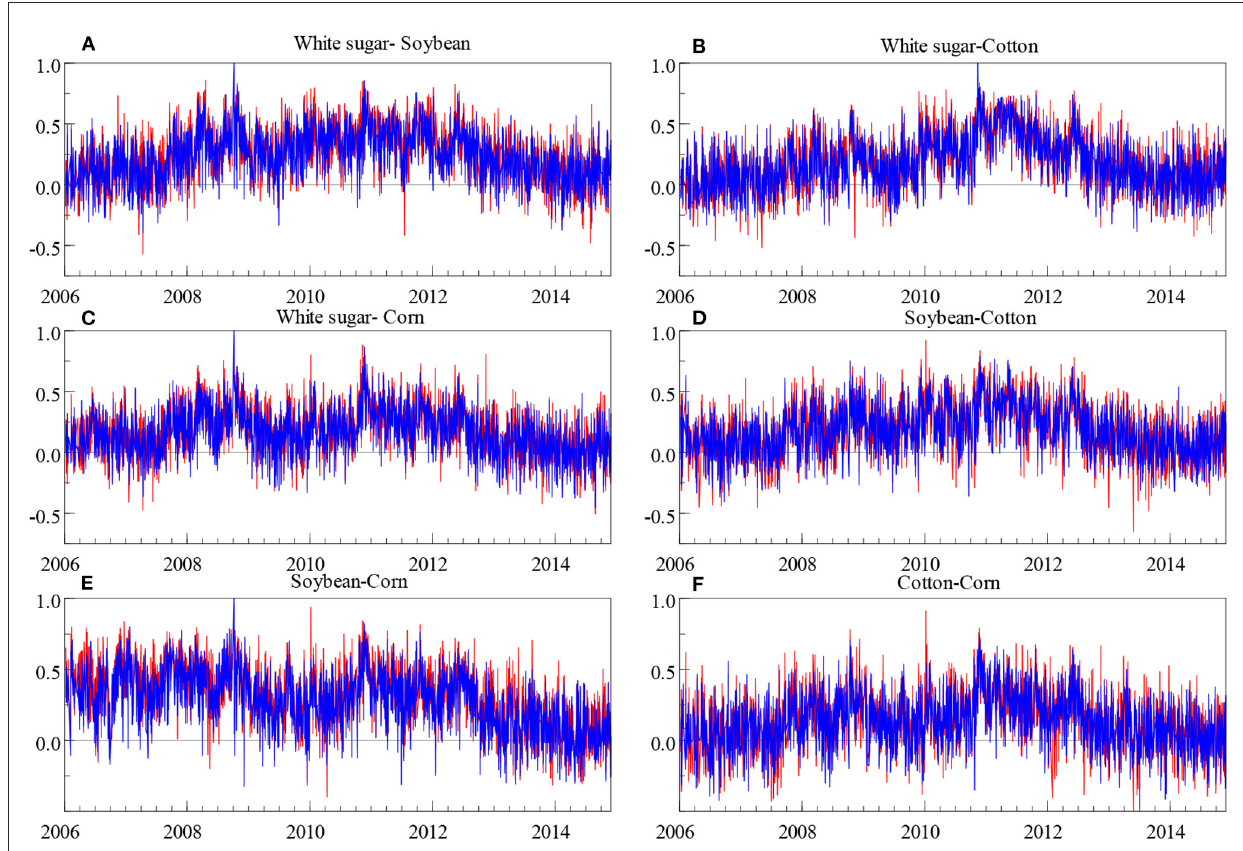
FIGURE3 Realized correlation (red line) and the intraday dependence (blue line) of white sugar-soybean (A) , white sugar-cotton (B) , white sugar-corn (C) , soybean-cotton (D) , soybean-corn (E) , and cotton-corn (F) .